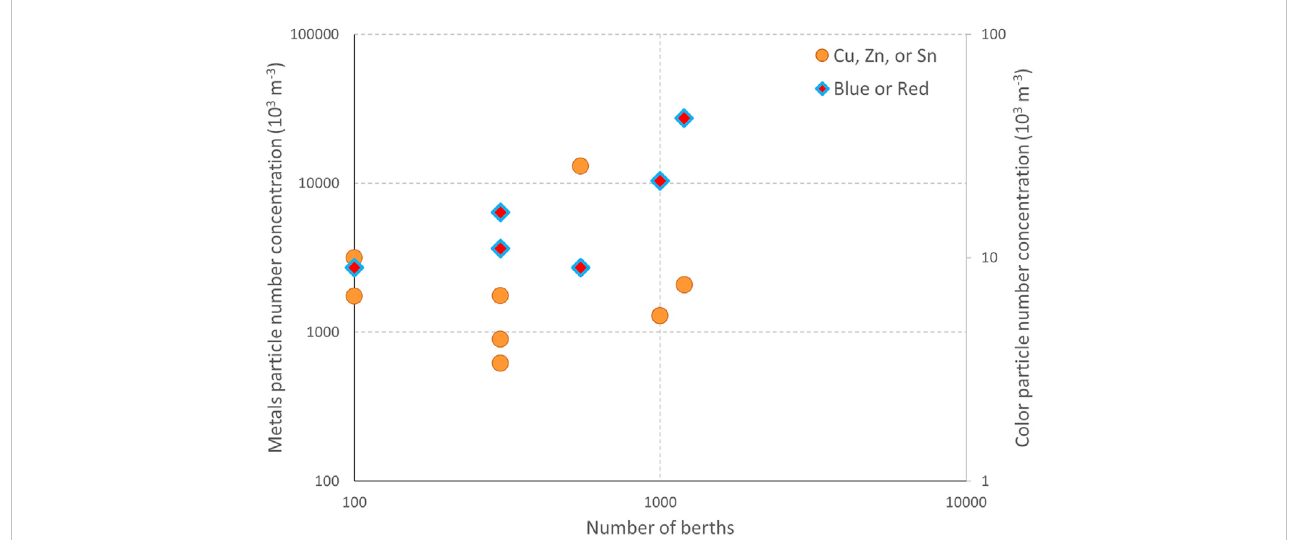
FIGURE 6 Numberconcentrationofthesumofparticlescontainingcopper,zinc,ortinabovethethreshold(5%oftheinorganiccontent)areplottedalongthesum of blue and red particles in samples collected with Ruttner sampler, fi ltered (10 µm), and detected with automated SEM-EDX and LM methods.